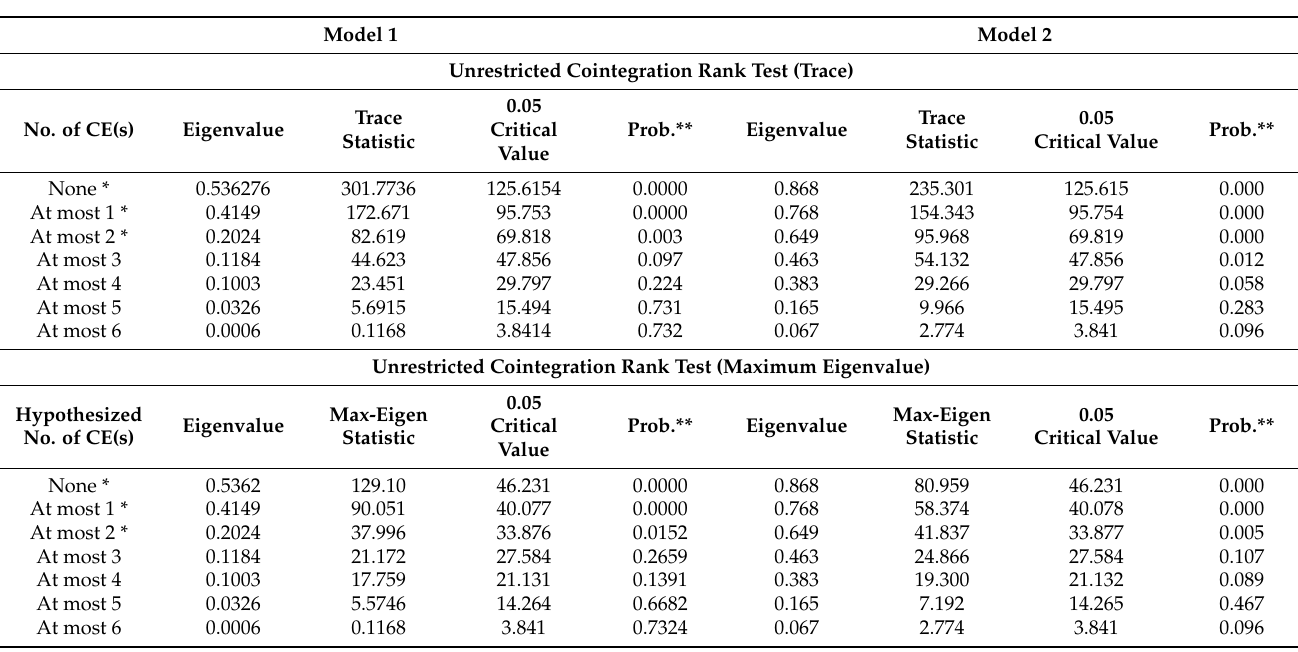
Table 5. Cointegration rank test (Trace) and rank test (maximum Eigenvalue).